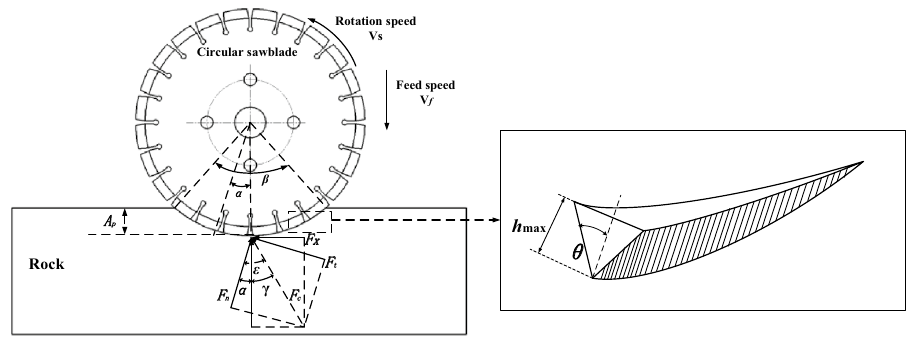
Figure 1. The circular saw blade cutting hard rock